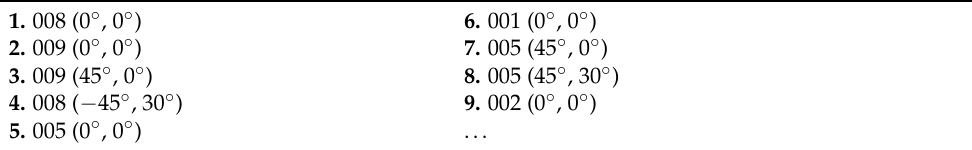
Table 3. An example of how the accuracy is computed in this paper: with the following nearest results in terms of Euclidean distance, if the subject to be recognized is “005”, the correct result is in the top-5 most similar mugshots and in the top-3 nearest identities (after “008” and “009”, the third recognized identity is